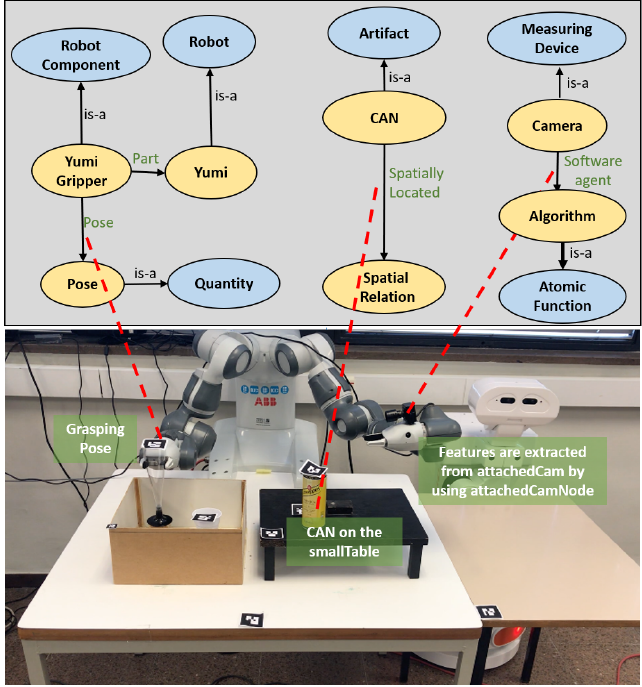
Figure 6. Description of some abstract manipulation knowledge